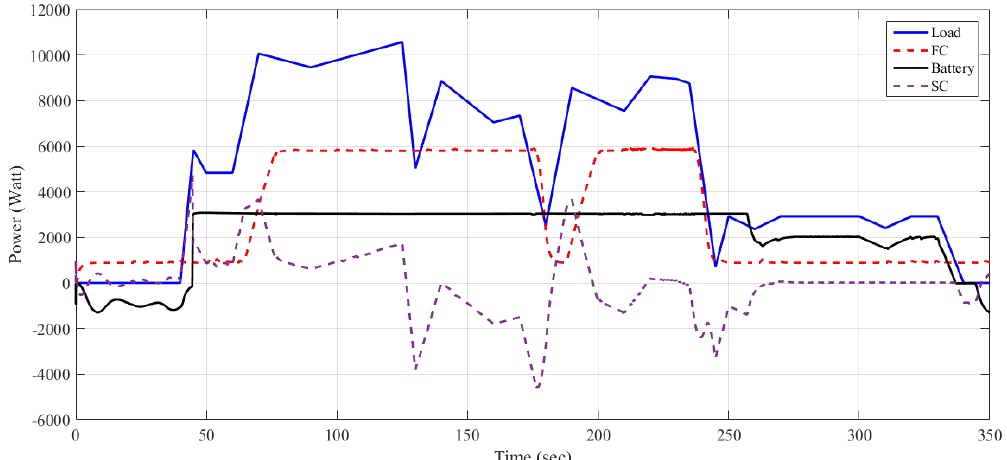
Figure 11. H 2 consumption variation in gm for different considered methods.